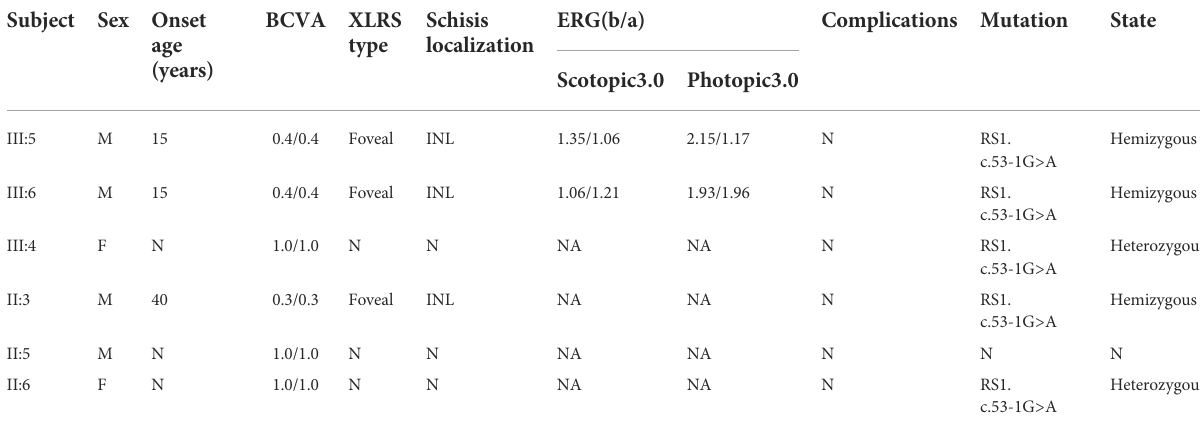
TABLE 1 Clinical data of patients with congenital